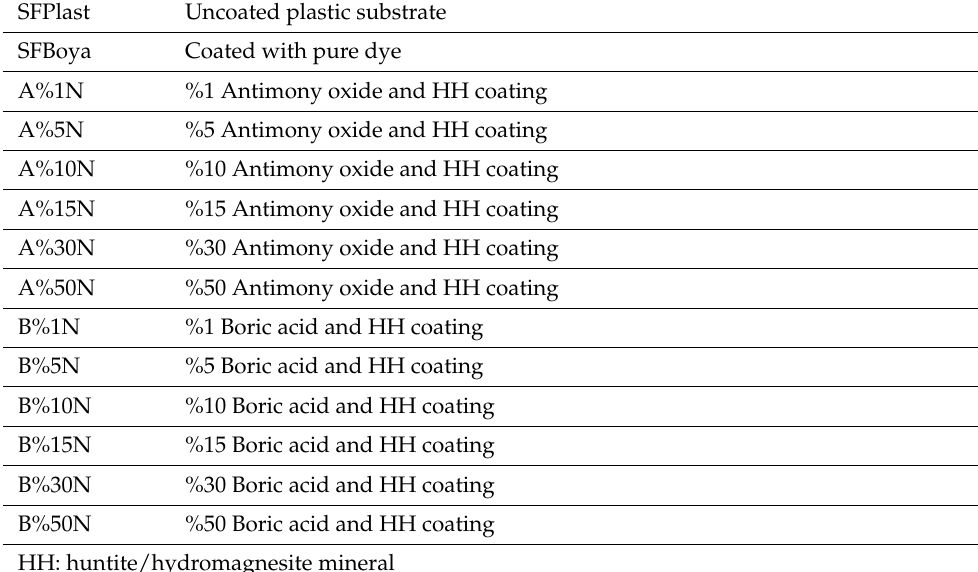
Table 2. Sample codes and